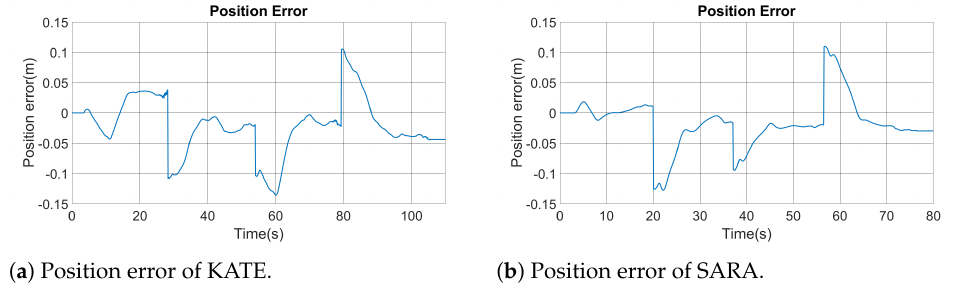
Figure 19. Position errors following the square paths.